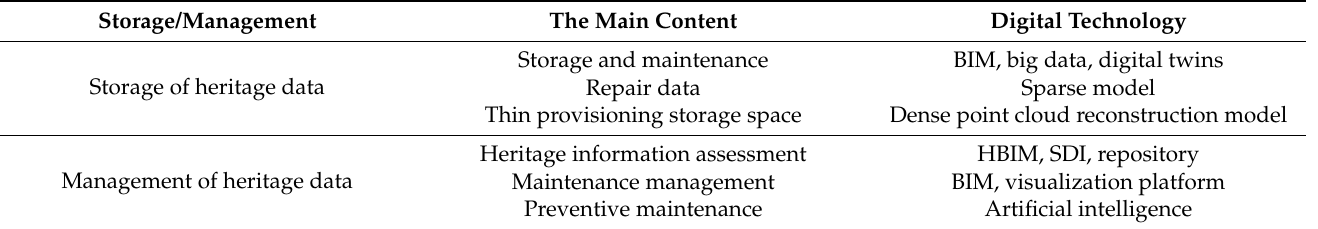
Table 3. Classification of storage and management